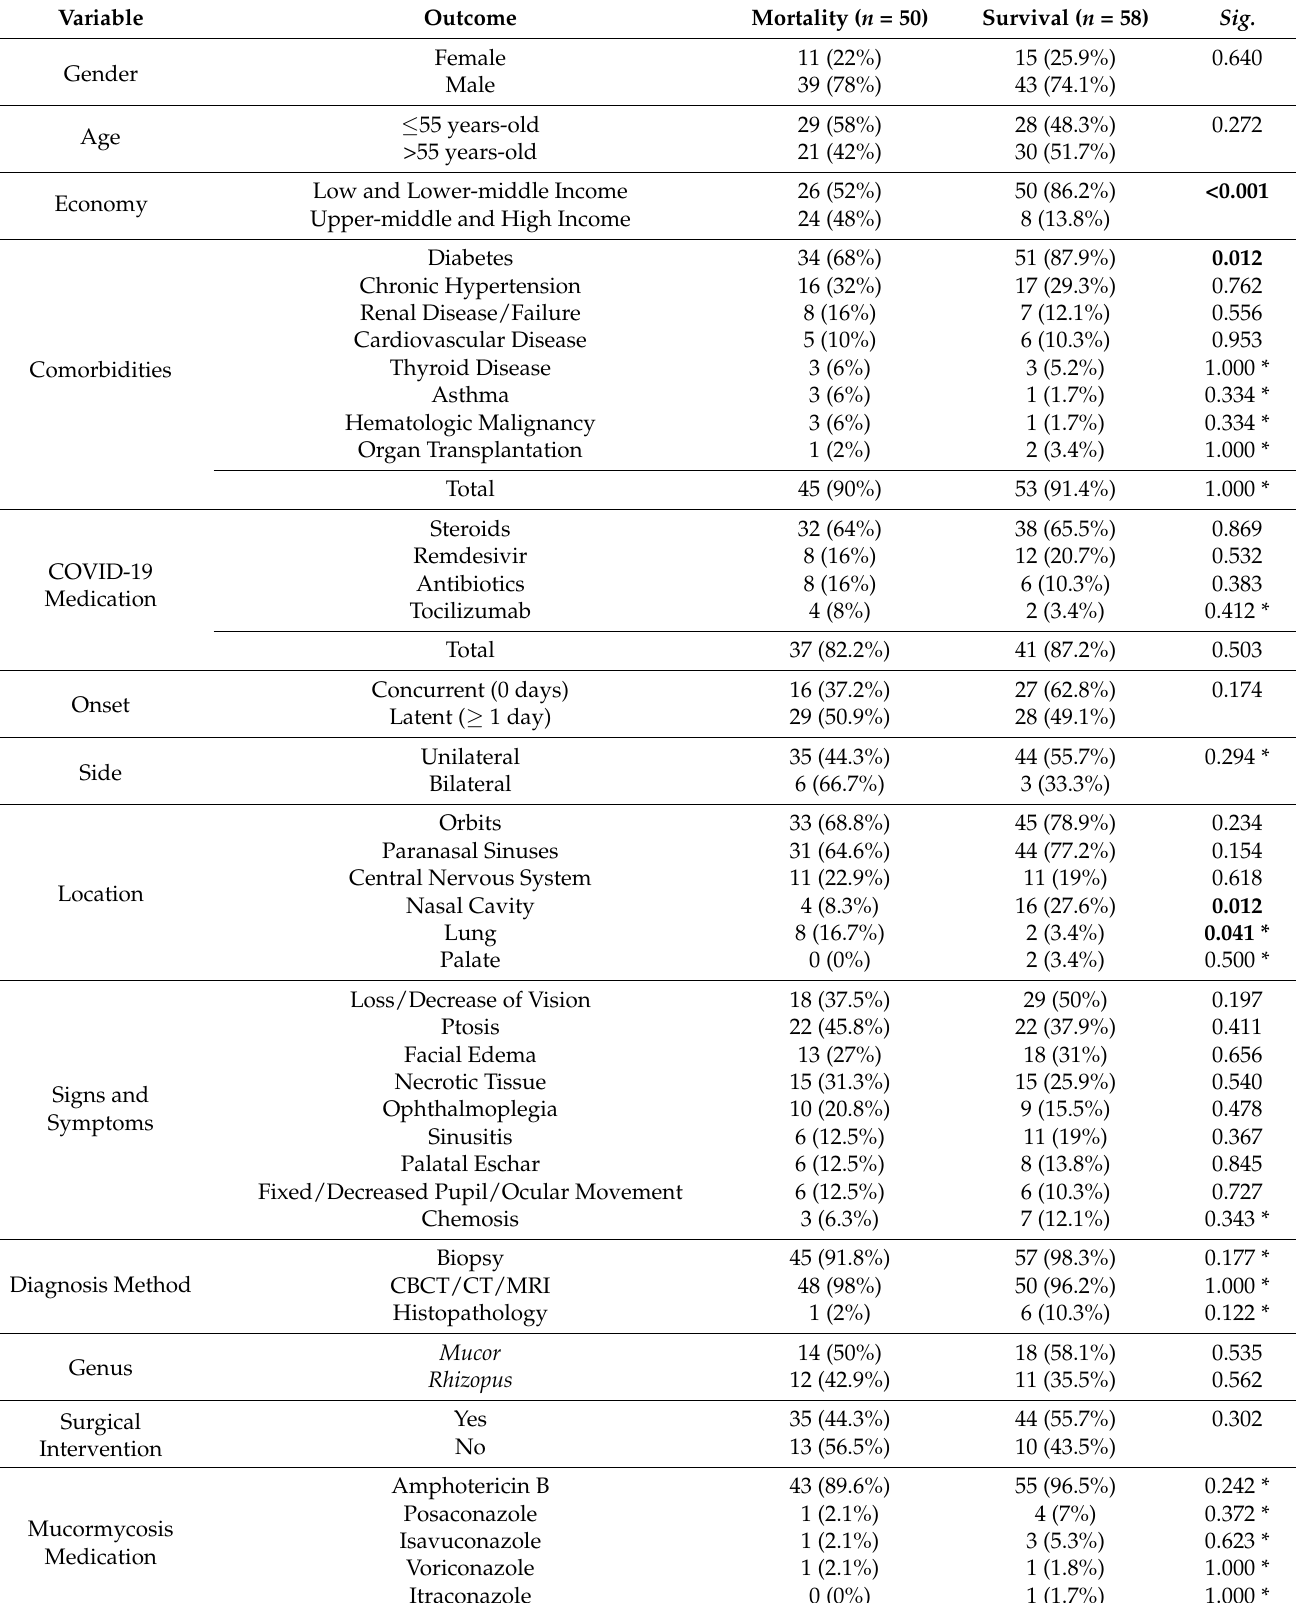
Table 7. Demographic, Anamnestic, Symptomatic, and Interventional Risk Factors of Mortality among COVID-19-associated Mucormycosis (CAM) Cases, Global Evidence Synthesis, January 2020–May